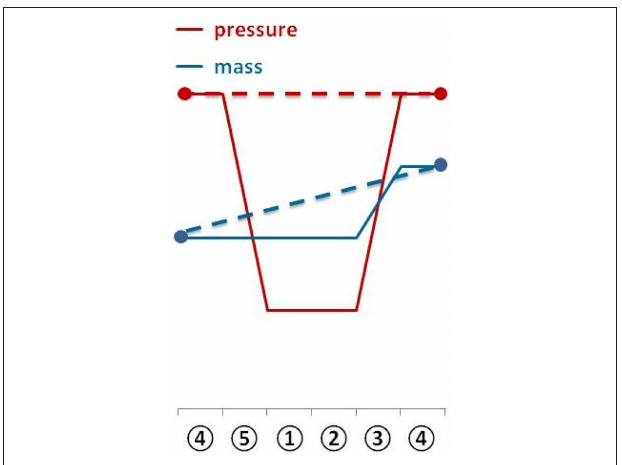
FIGURE 2 | The diagram shows the change of serum bottle mass and serum bottle headspace pressure during one experimental run.